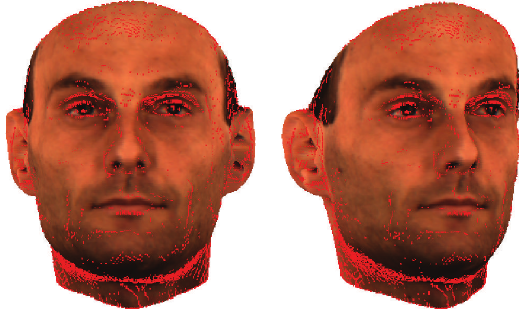
Figure 3: The collision points on the destination 3D face.